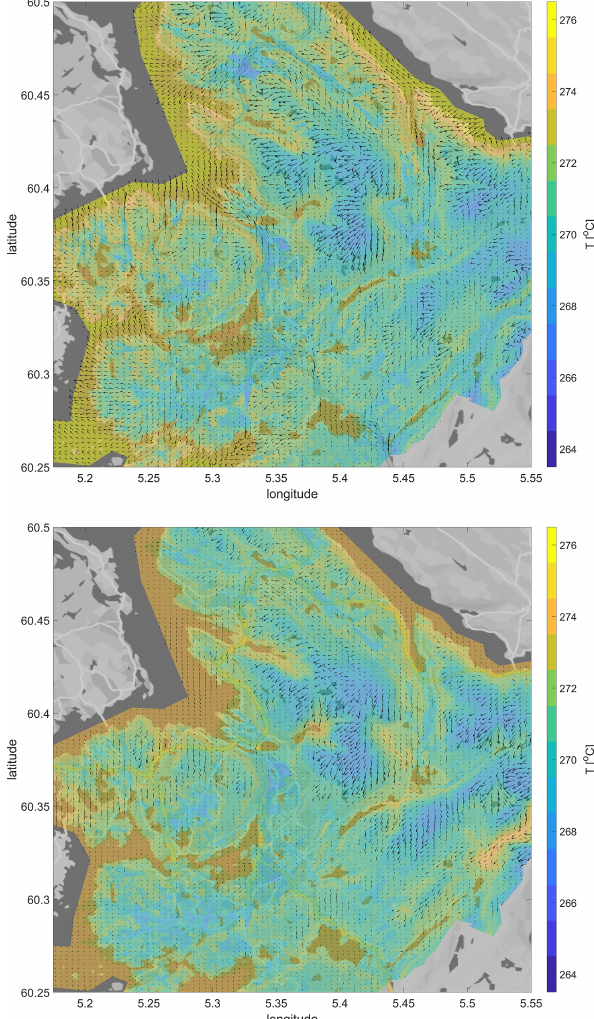
Figure 2. Surface-layer meteorology obtained from PALM sim- ulations for scenarios 1 (top) and 2 (bottom). The color shading represents the surface air temperature at 2m above the ground (terrain-following temperature field). Vectors represent the surface- layer wind at 10m. Data overlay the grayscale map from © Google Maps